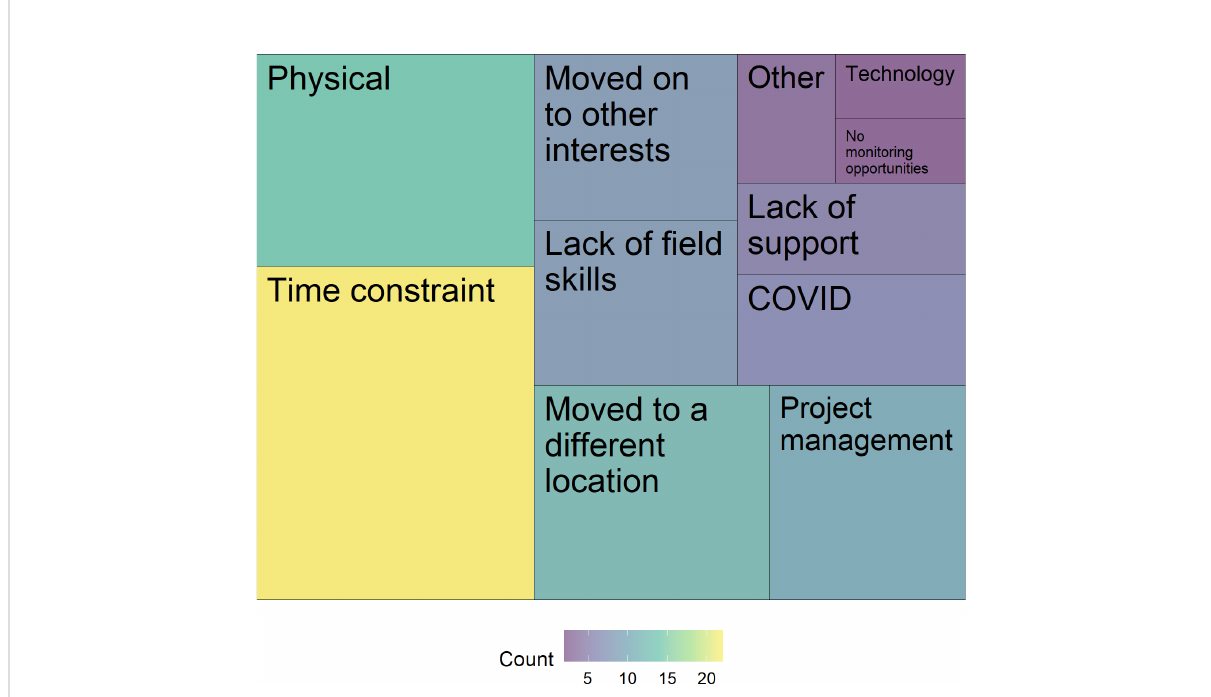
FIGURE 7 Reason why inactive participants (n = 84) are no longer active in the project. Across all projects, the #1 reason was time constraint (n = 22), followed by physical demands (14) and moving to a different location